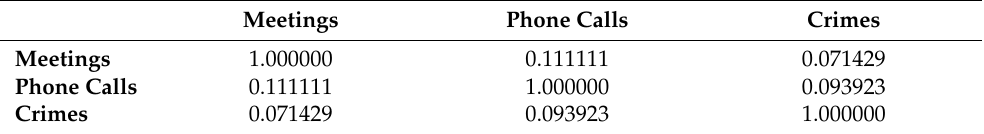
Table 6. Jaccard overlapping of the edges in the Montagna multiplex network.